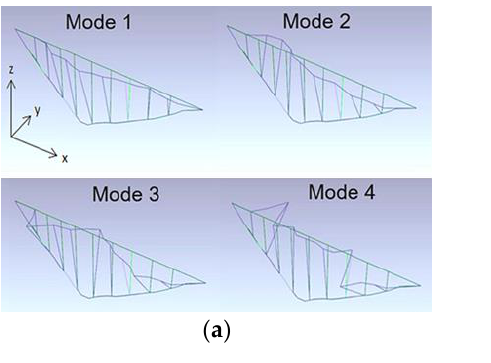
Figure 9. The Ponte delle Torri, Spoleto, Italy: ( a ) modal shapes of the first four modes by OMA techniques; ( b ) original frame of the recorded video with a detail of the lamppost (red arrow) on the upper wall of the pedestrian deck.